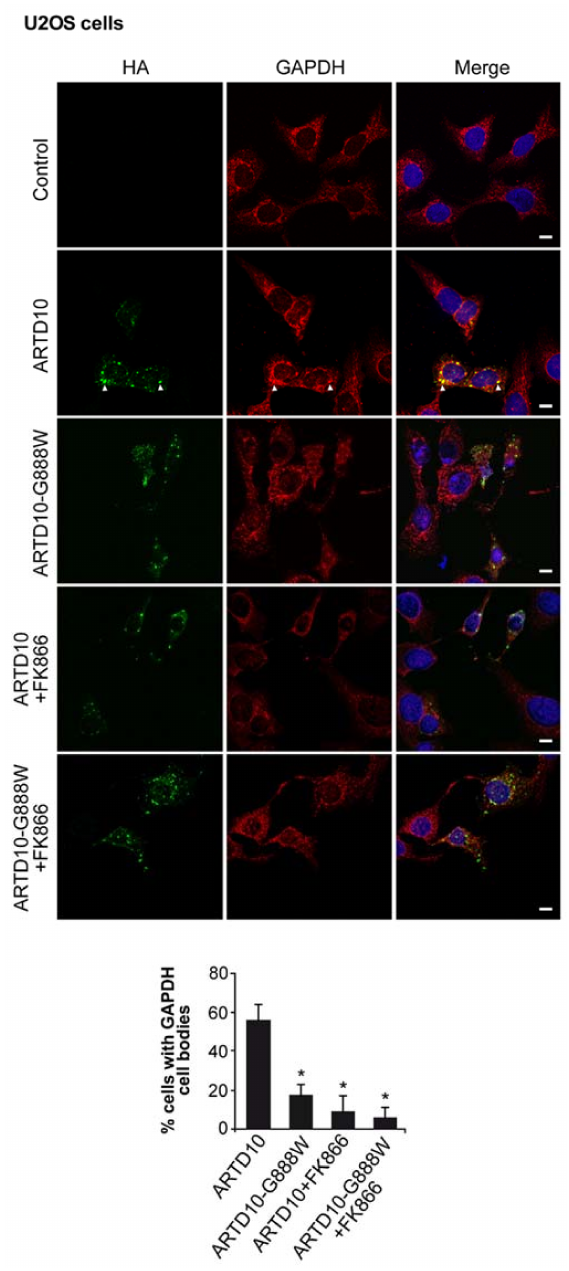
Figure 5. Staining of overexpressed ARTD10/PARP10 and endogenous GAPDH in U2OS cells. Representative immunofluorescence microscopy of U2OS cells that were mock transfected (Control) or were transiently transfected with HA-ARTD10 or HA-ARTD10-G888W, without or with treatment with FK866 (HA-ARTD10 + FK866, HA-ARTD10-G888W+FK866). Scale bars, 10 µ m. See legend to Figure 4 for further details. *, p < 0.01.